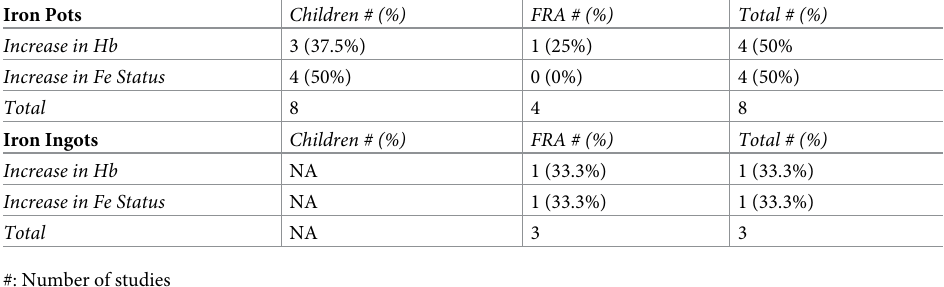
Table 2. Number and percentage of studies demonstrating statistically significant increases/differences in Hb and Fe status among children vs. FRA. Iron